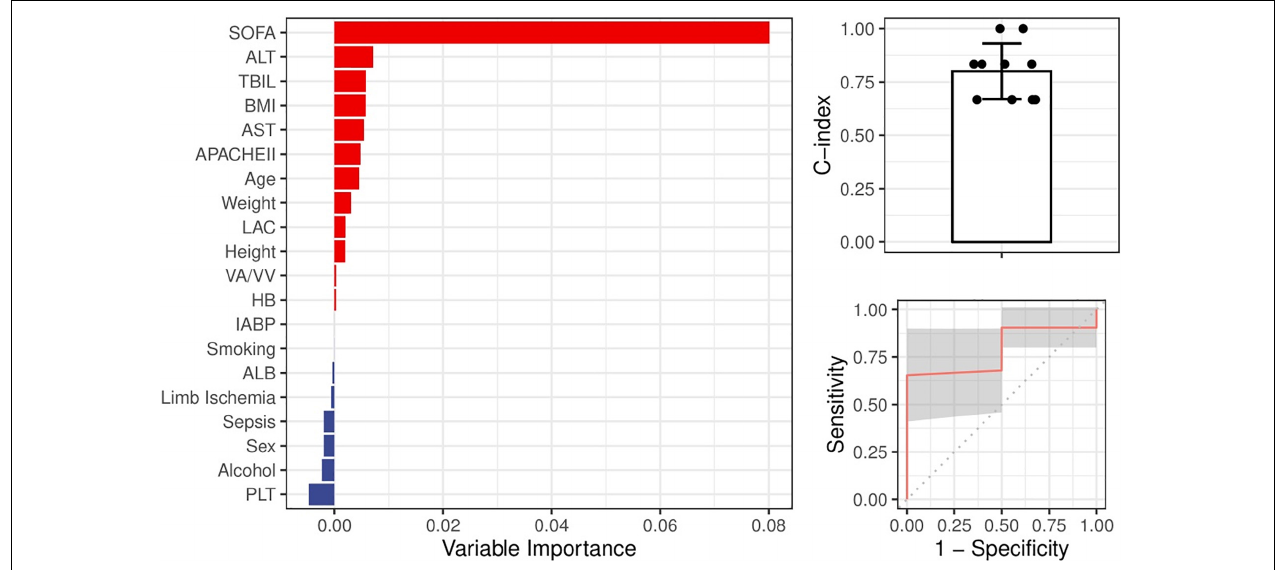
FIGURE 5 | Ranking of the potential indictors for the occurrence of high TBIL during ECMO based on the random forest algorithm. All variables were demographic features or parameters obtained before ECMO. A greater importance value suggested a closer relationship between the variable and the occurrence of high TBIL during